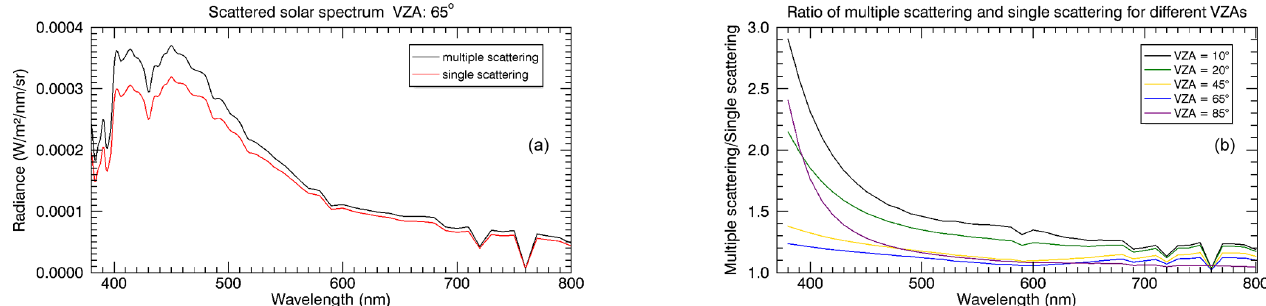
Figure 15. (a) Solar scattering spectra for VZA = 65 ◦ with the multiple scattering (black line) and without the multiple scattering contribu- tion to the total scattered radiance (red line). (b) Ratio of multiple scattering and single scattering for different VZAs. For all simulations, SZA = 98 ◦ and SAA = 0 ◦ . The NLC parameters are the following: r m = 50nm, S = 1 . 4, τ NLC = 10 − 4 and z NLC =